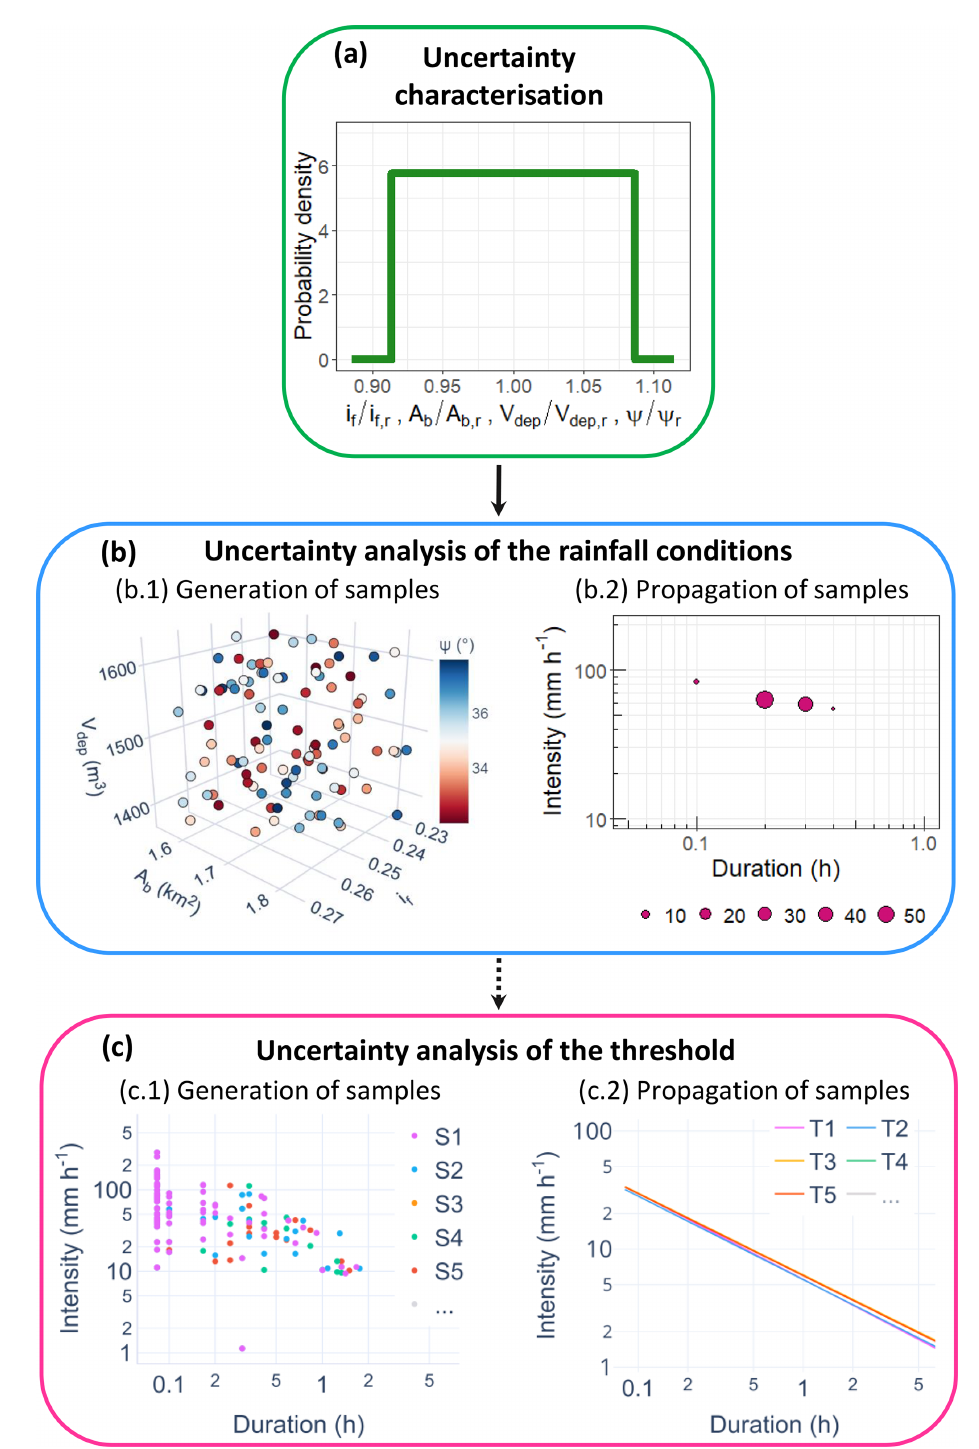
Figure 3. Scheme of the uncertainty analysis performed with two cascade MC simulations. (a) Uncertainty characterisation of the parameters and data: the non-dimensional form of the uncertain parameters and data, obtained by dividing the variables by the reference values, are assumed to be uniformly distributed. (b) First MC simulation to compute the uncertainty analysis of the event characteristics for each debris flow: (b.1) sample generation performing the Latin hypercube sampling (LHS) and (b.2) propagation of samples to compute the event characteristics. The dot size in the log–log I – D plane indicates the absolute frequency of obtaining the (I,D) couples. (c) Second MC simulation to perform the uncertainty analysis of the threshold: (c.1) random sample S generation (one of the previous obtained (I,D) couples for each event) and (c.2) propagation of samples to estimate the thresholds T